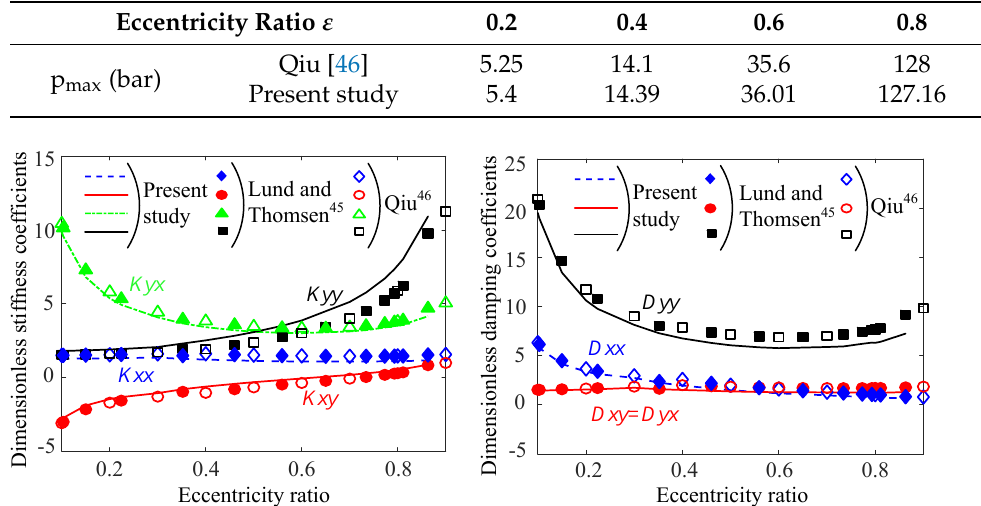
Table 3. Maximum pressure for various eccentricity ratios.